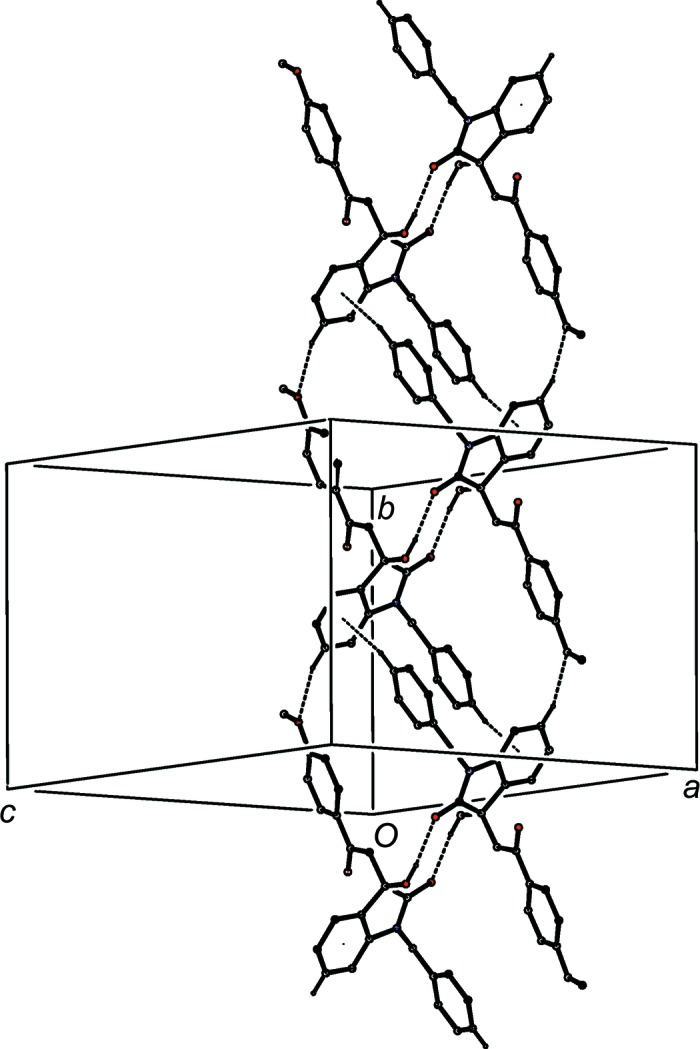
Part of the crystal structure of com­pound (Ic), showing the formation of a chain of rings built from O—H⋯O, C—H⋯O and C—H⋯π(arene) hydrogen bonds. Hydrogen bonds are drawn as dashed lines and, for the sake of clarity, H atoms not involved in the motifs shown have been omitted.